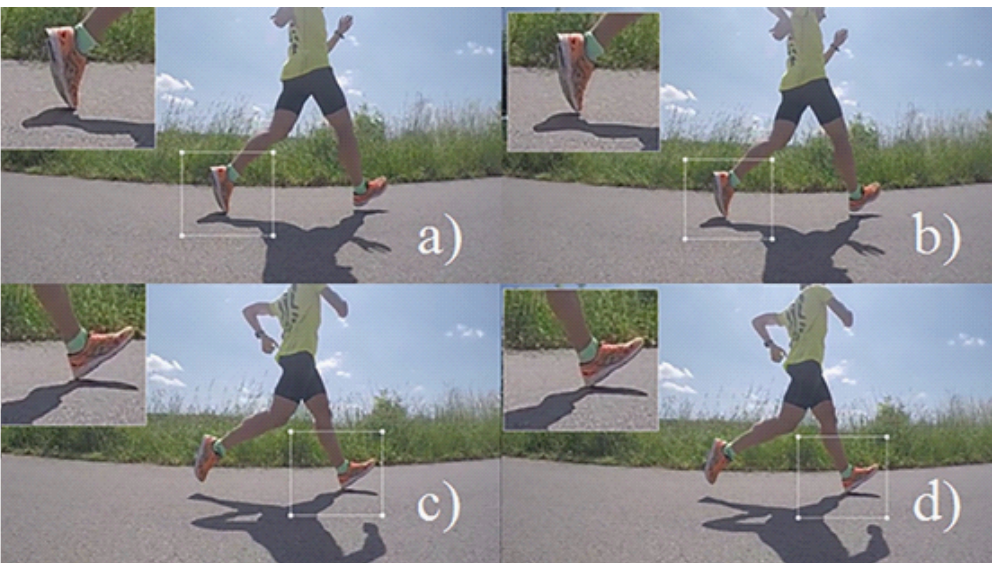
Figure 10. Photo sequence with magnifying glass focused on the left foot (near the TOE, upper pictures) and on the right foot (near the HSE, bottom pictures). ( a ) Last image with visible ground contact of left foot. ( b ) First image without the last visible ground contact of left foot. ( c ) Last image without visible ground contact of right foot; ( d ) First image with visible ground contact of right